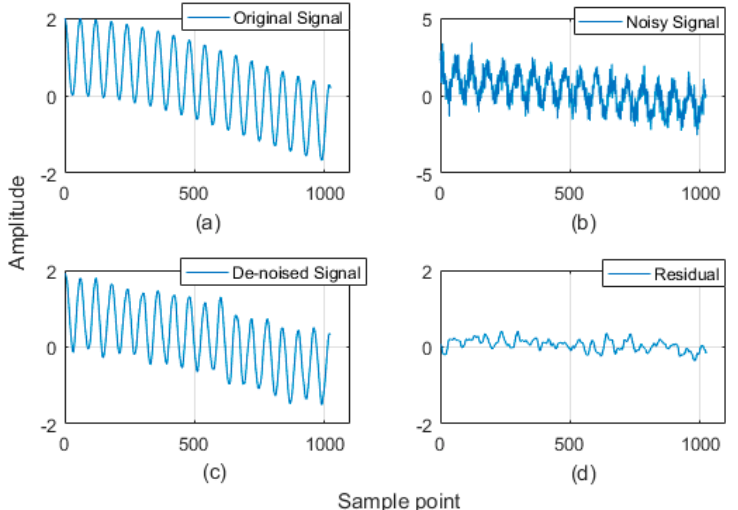
Figure 3. Reconstruction results and comparisons: ( a ) original signal; ( b ) original signal added with noise; ( c ) de-noised signal by using SSA-AND; ( d ) residual.